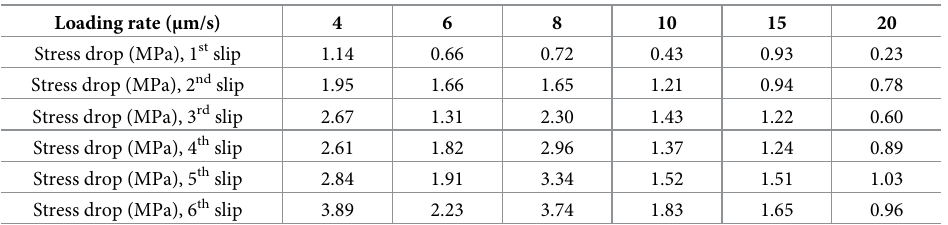
Table 1. Stress drop